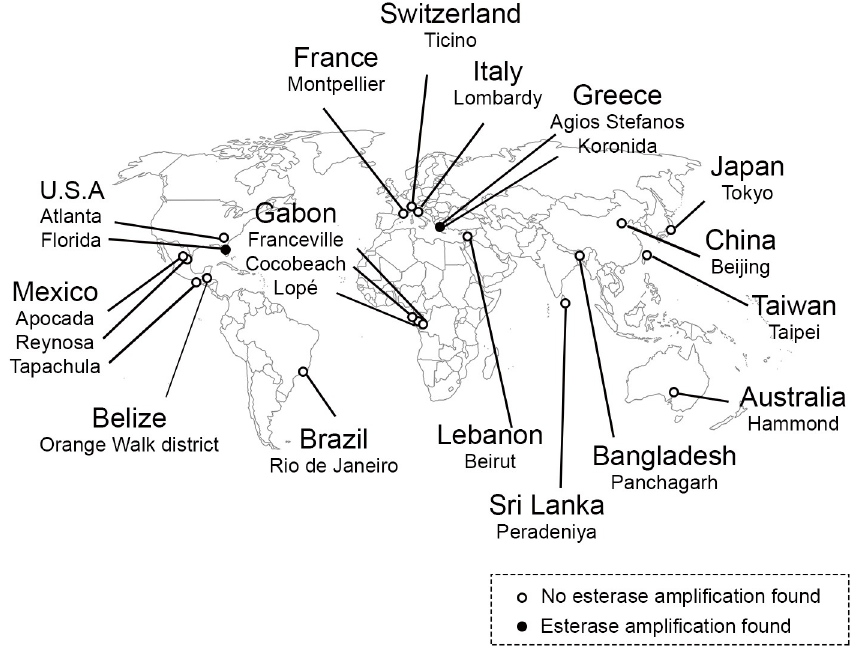
Fig 1. Sample collection map. The countries of origin for the 385 individuals screenedfor CCEae3a and CCEae6a gene amplification are indicated . Black and white circles respectivelyrepresent places were amplification was or not